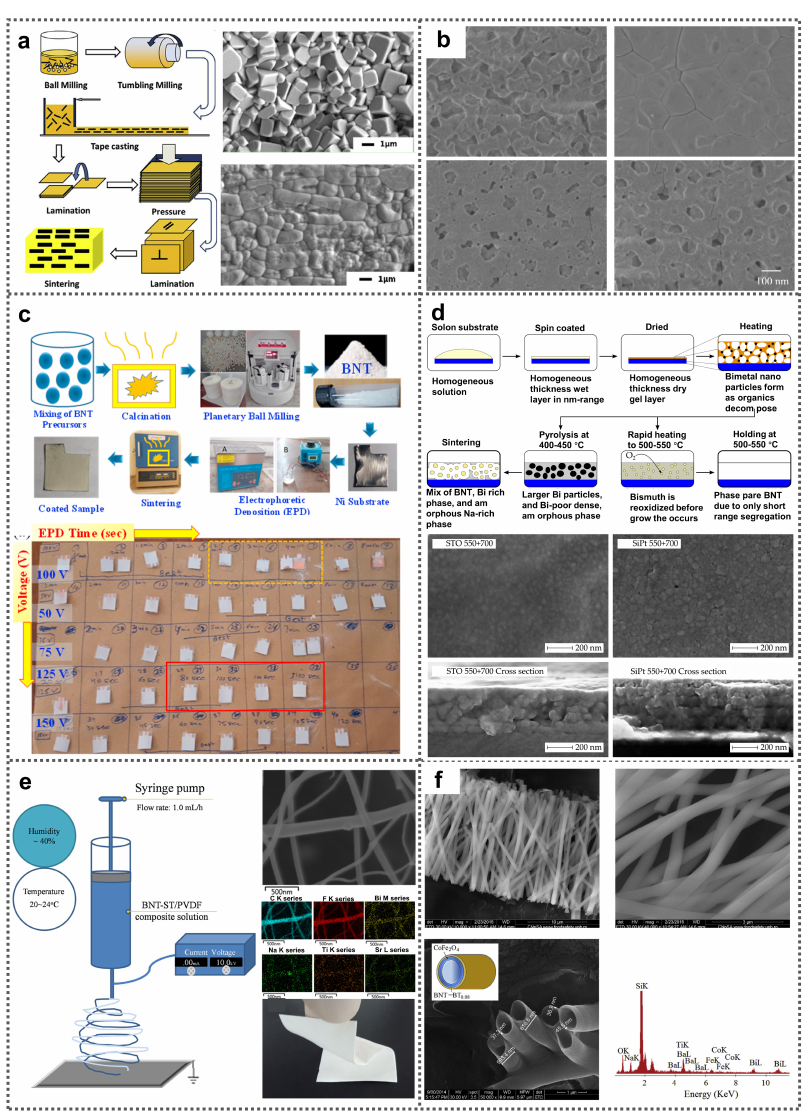
Figure 1. Material design and preparation of BNT ferroelectric nanomaterials. ( a ) Fabrication process and SEM images of <001> textured piezoelectric BNT-BKT-xST ceramic samples prepared through template-aided grain growth method (Reproduced with permission from [28], Elsevier, 2014). ( b )